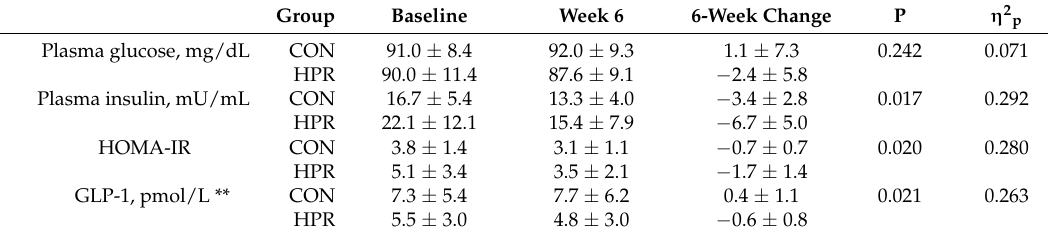
Table 4. Fasting blood indices at baseline and week 6, and 6-week change data, in overweight adults on an energy-restricted diet composed of traditional breakfast cereal and gluten-free pasta dishes at lunch and dinner (CON; n = 11) or high-protein breakfast cereal and high-protein pasta dishes at lunch and dinner (HPR; n = 10) * .